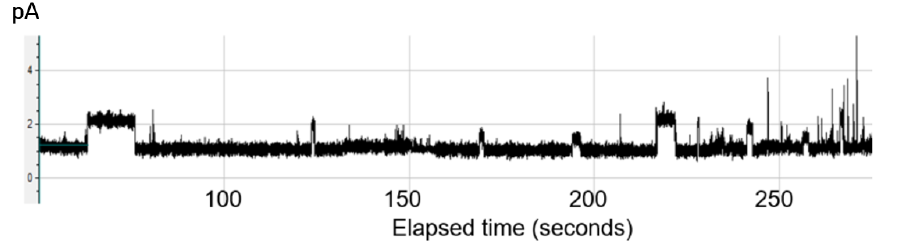
Figure 4. Planar bilayer results for W-C 12 -W ( 6 ). After some initial evidence of conductance, only spiking behavior (right of trace) could be observed.